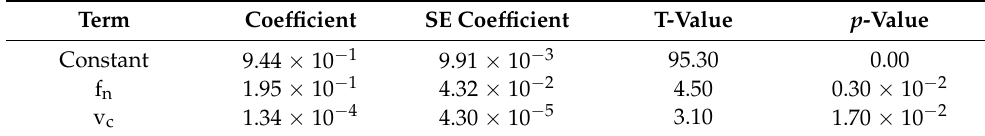
Table 11. Linear regression